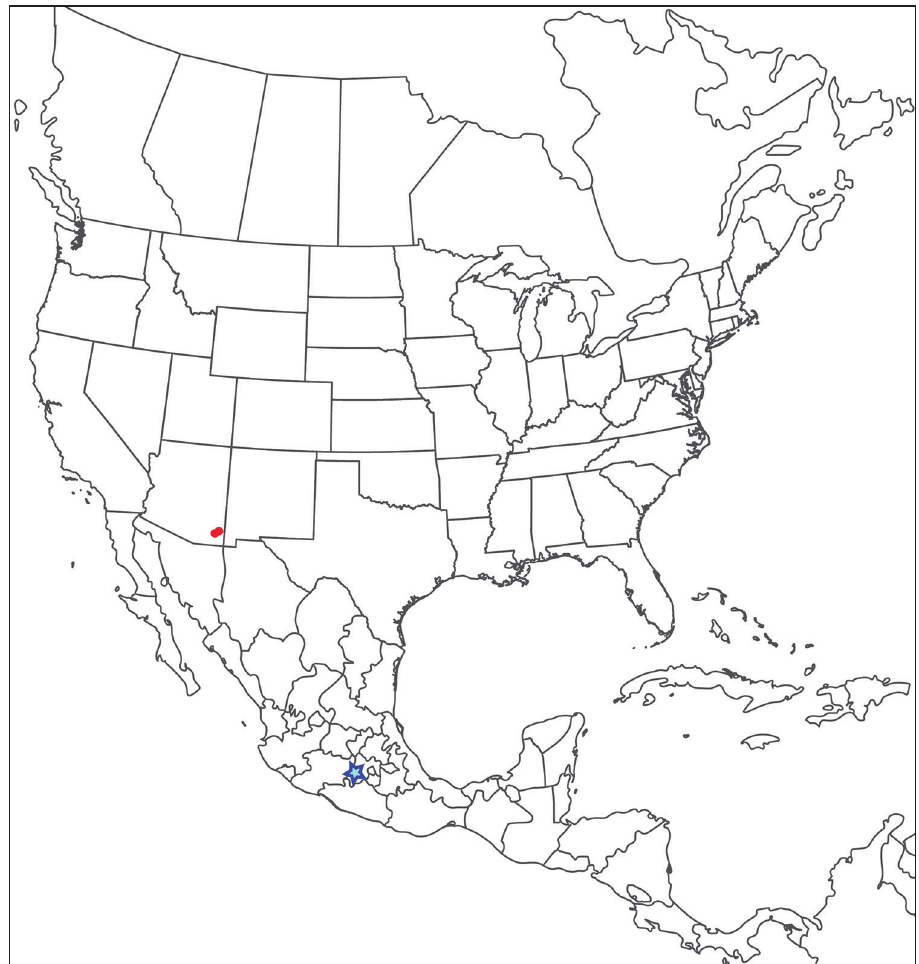
Figure 120. Torrenticola kurtvietsi distribution. Blue star represents type locality (Cramer 1992); red circles represent new record and material